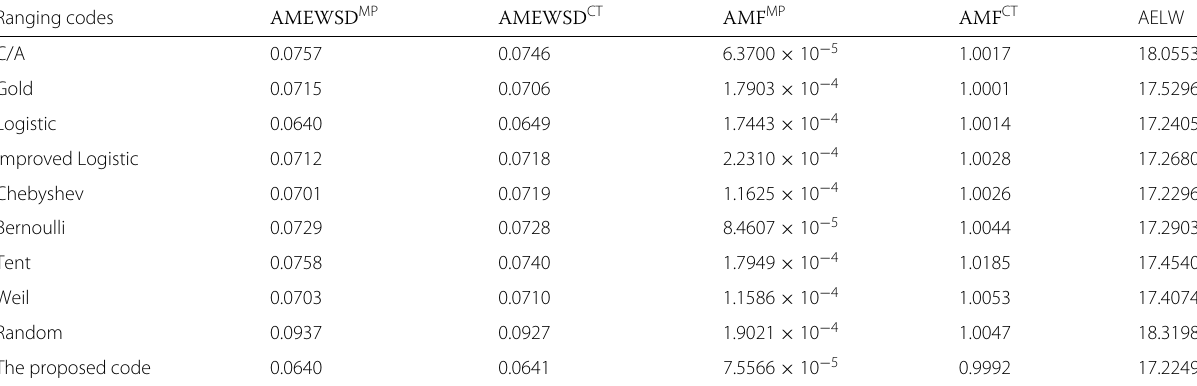
Table 2 The comparison of performance indexes for various ranging codes Ranging codes